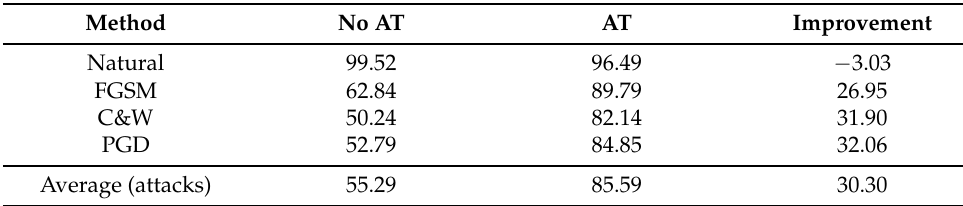
Table 4. Performance comparison under PSR = − 32 dB for Dataset